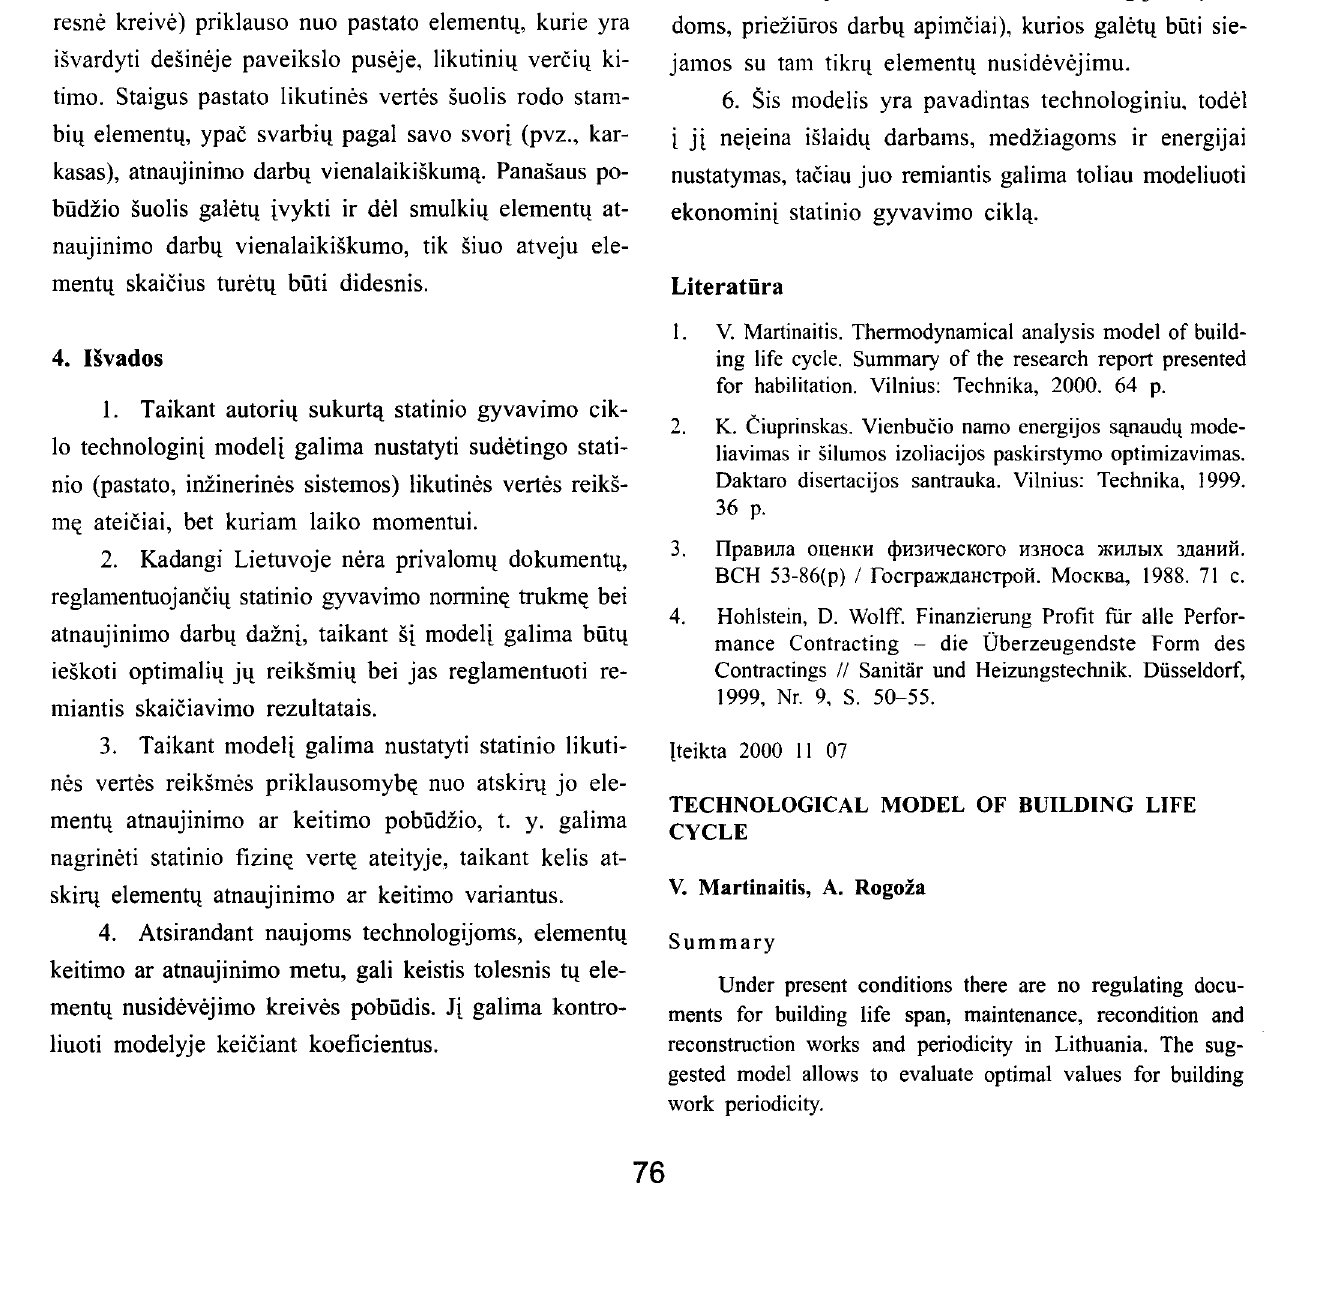
Fig 6. Depreciable value of building and its elements 5. Atskifl!_ elementl!_ pakeitimas ar atnaujinimas turi itakos ne tik statinio estetiniam vaizdui, ilgaamzisku mui, bet ir eksploatacinems islaidoms (energijos S<tnau doms, prieziiiros darb4_ apimciai), kurios galet4_ biiti sie jamos su tam tikr4. element4_ nusidevej